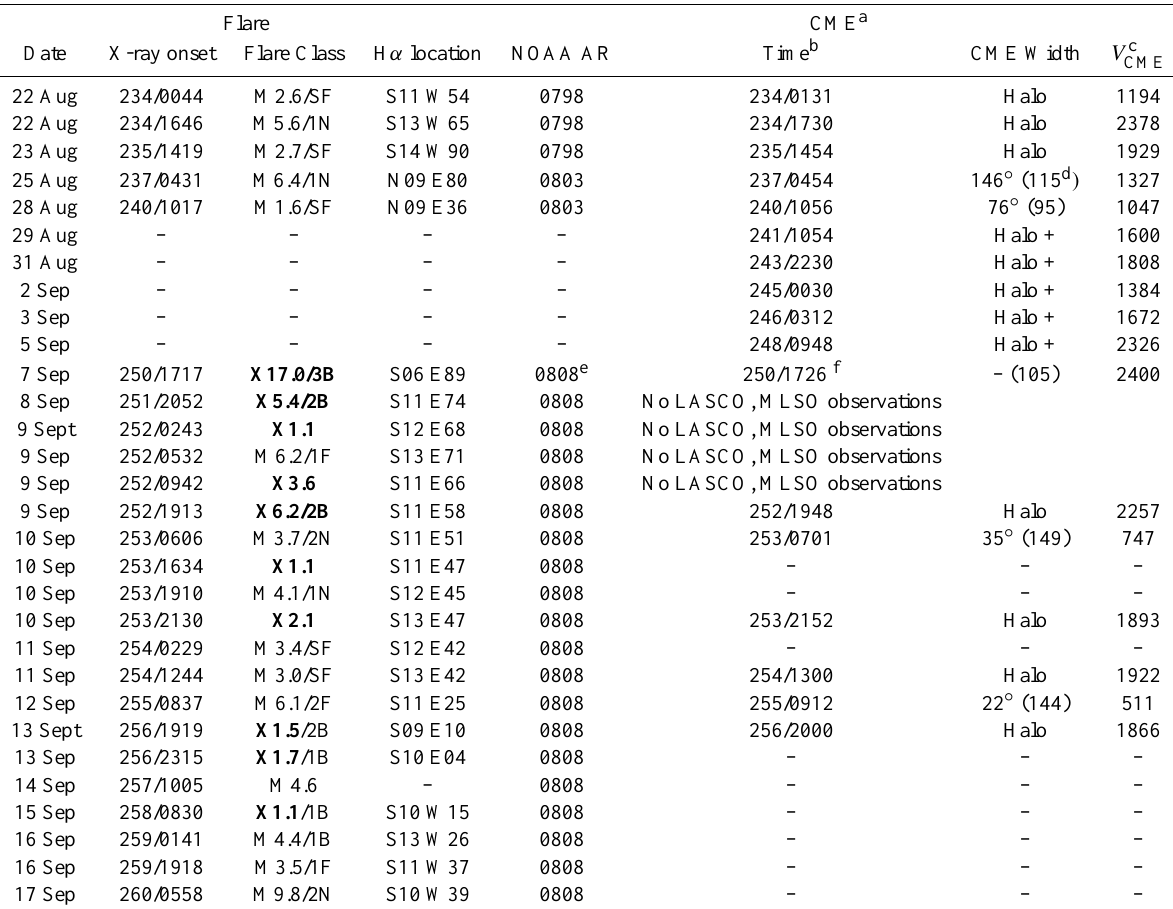
Table 1. Reported Solar Events relevant to the studied particle events from 22 August to 17 September